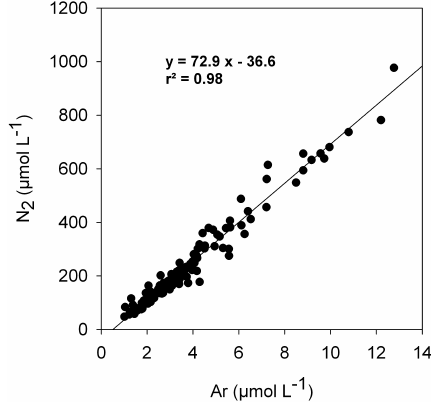
Figure 2. Concentrations of N 2 in ice plotted against the concen- trations of Ar in ice. The equation and r 2 are calculated assuming a linear regression between both gas